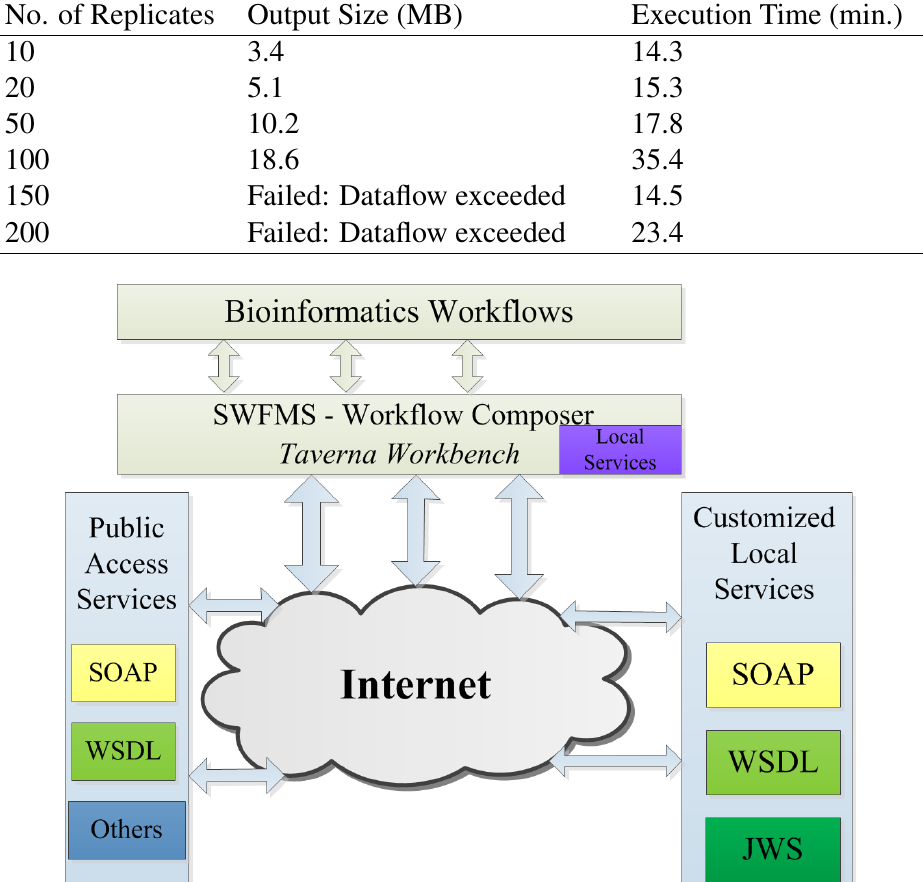
Figure 4: The proposed architecture for better locality exploitation for the Taverva workflow